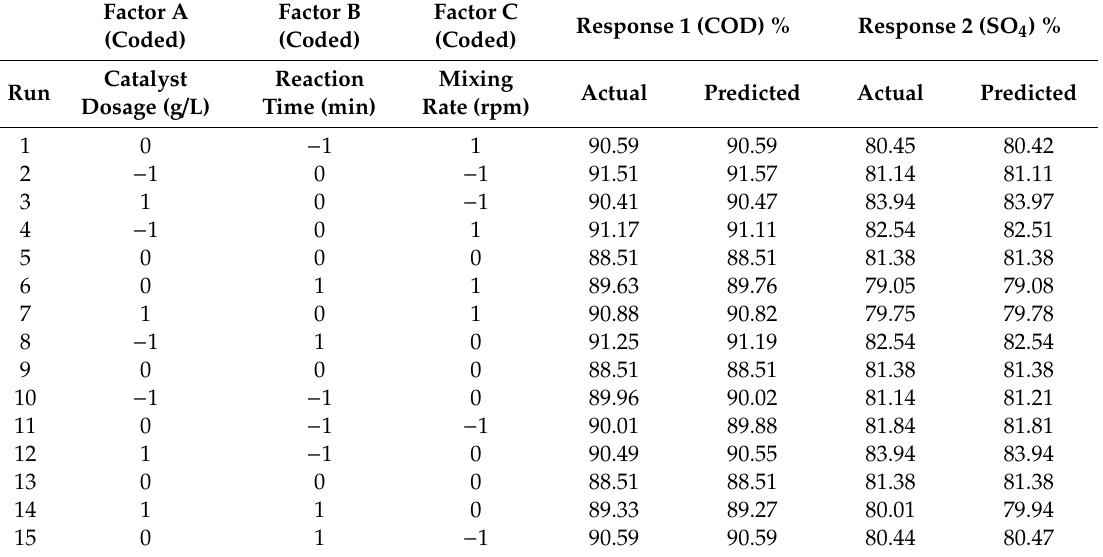
Table 4. Coded matrix and response values for TiO 2